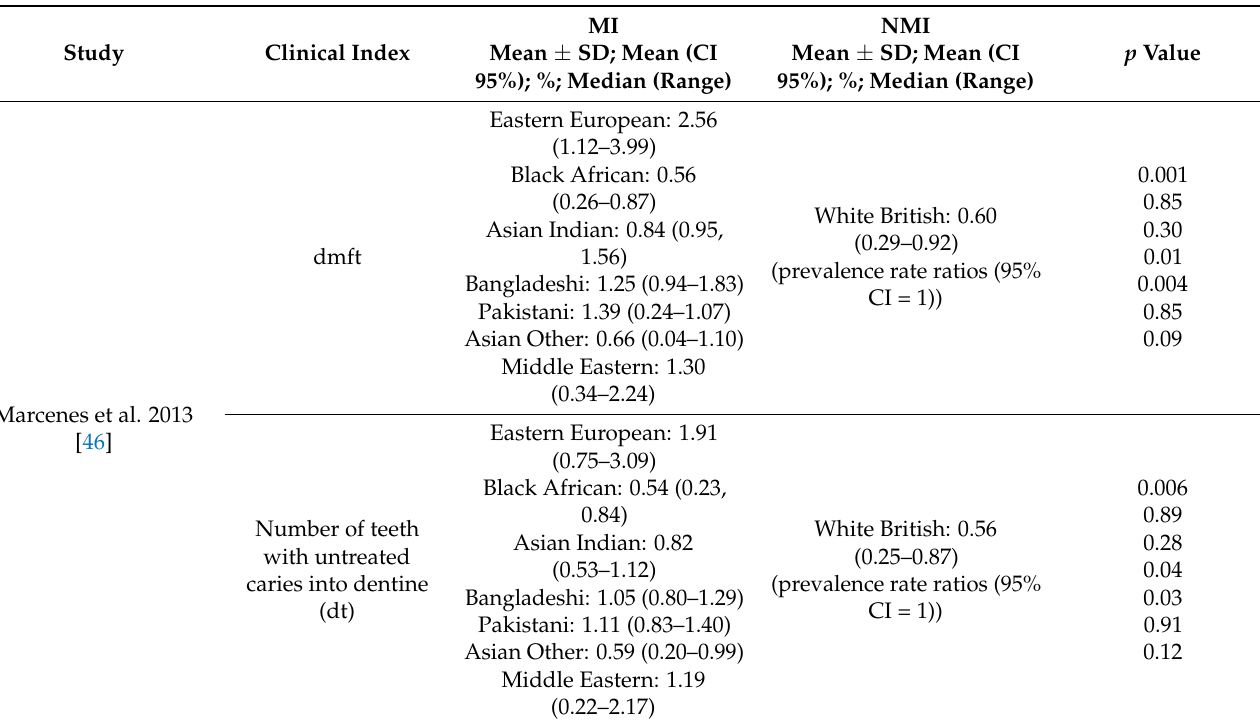
Table 13. Dental caries in MI and NMI living in United